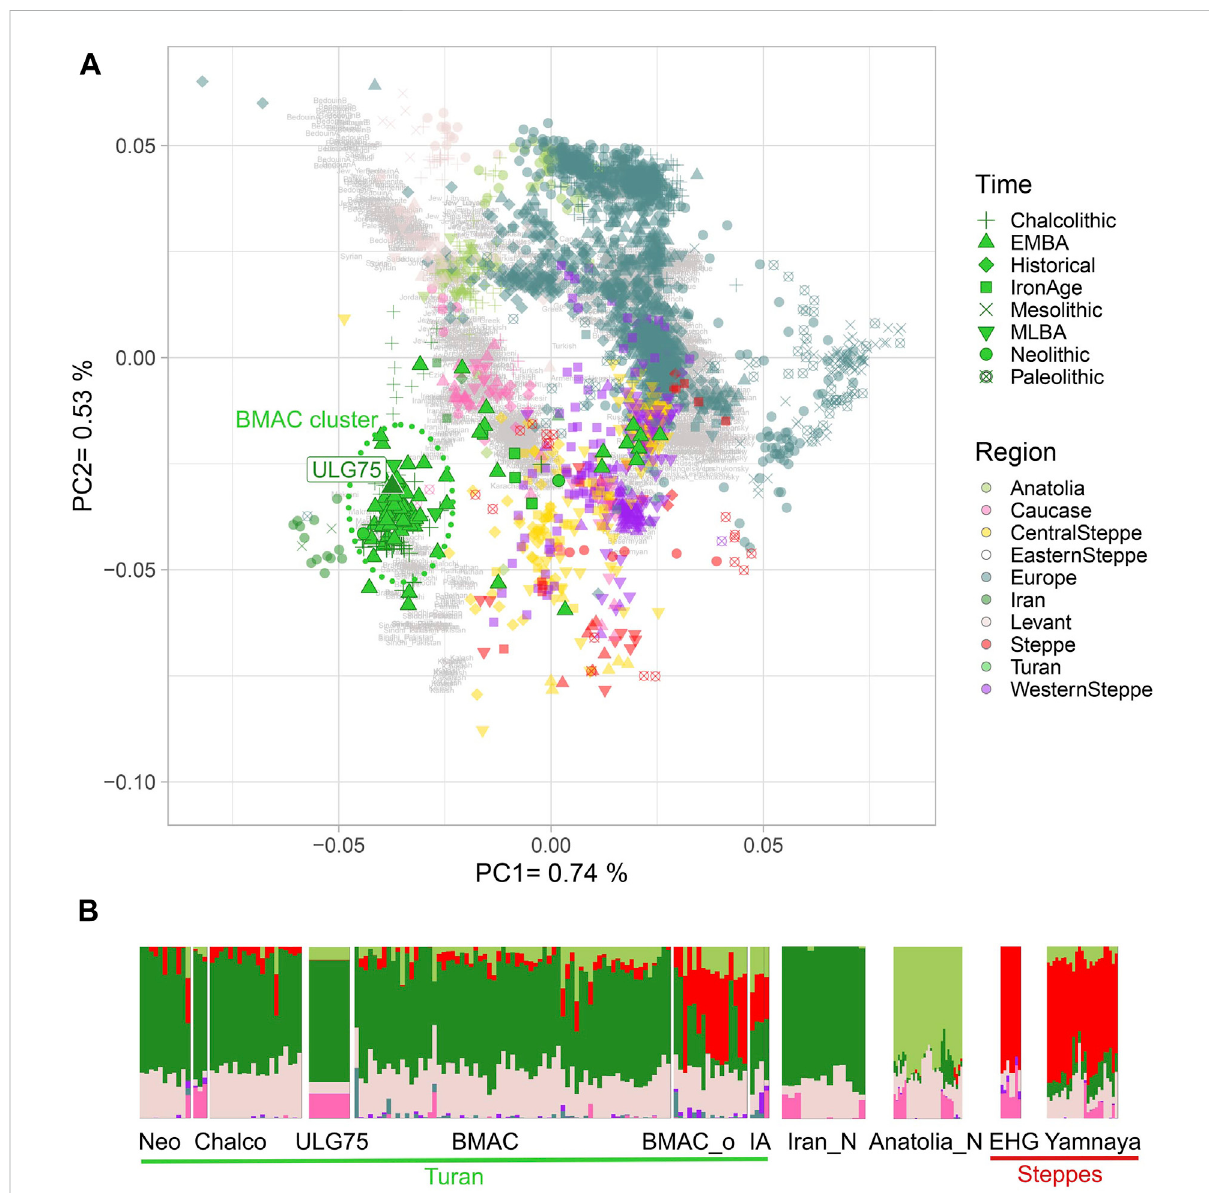
FIGURE 2 Geneticaf fi nityof ULG75 withotherTuranindividuals. (A) PCAiscalculatedonpresent-dayindividualswithancientindividualsprojectedontoit. Ancient Turan individuals are shown in non-transparent green with outlines. ULG75 individual is labeled. (B) Unsupervised ADMIXTURE analysis was performed on the HO-dataset. Only ULG75 , ancient Turan individuals, Neolithic Iranian Anatolian farmers, and Paleolithic and Eneolithic steppe populations are shown. Full ADMIXTURE is available in the supplementary data. Neo, Neolithic; Chalco, Chalcolithic; BMAC_o, outliers from BMAC sites; IA, Iron Age; Iran_N, Neolithic Iranian farmers; Anatolia_N, Neolithic Anatolian farmers; EHG, Eastern